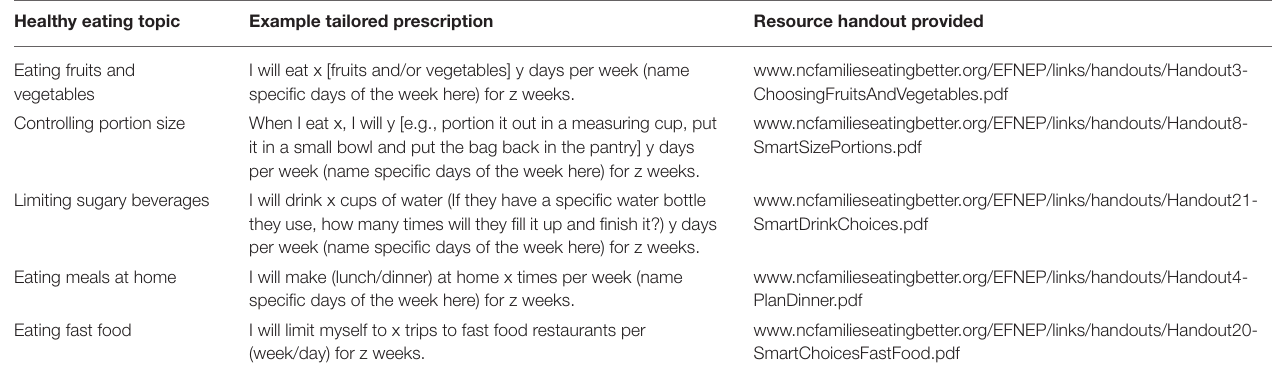
TABLE 1 | Comparison healthy eating prescriptions.